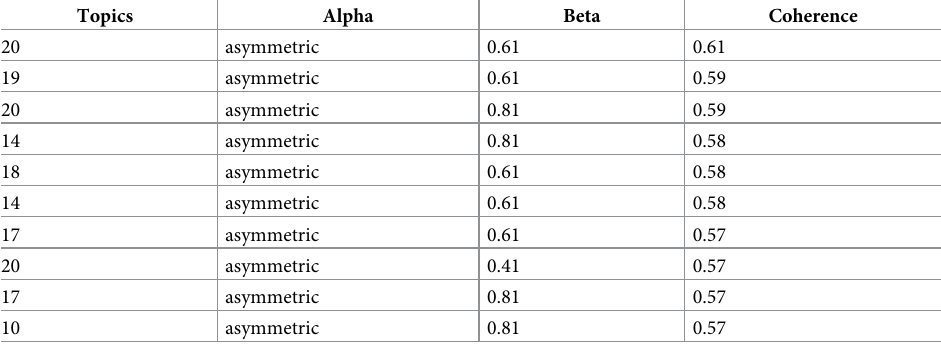
Table 2. The top ten models and their hyperparameters based on coherence